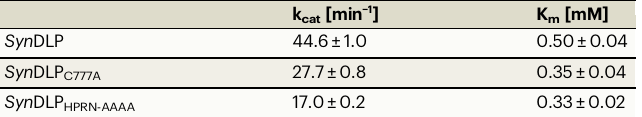
Table 3 | Kinetic parameters describing the GTPase activity of Syn DLP